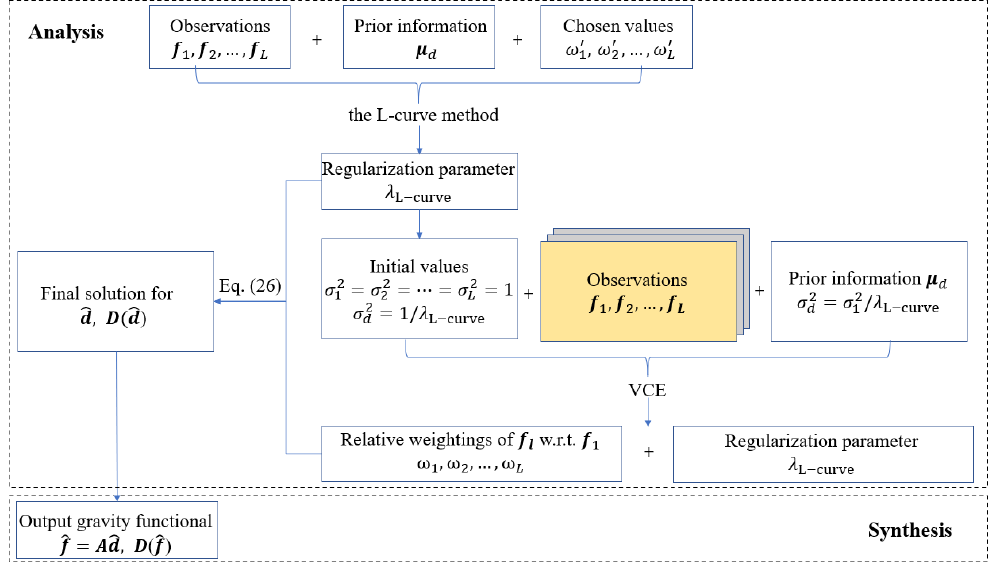
Figure 4. Analysis and synthesis for combining different types of observations based on the